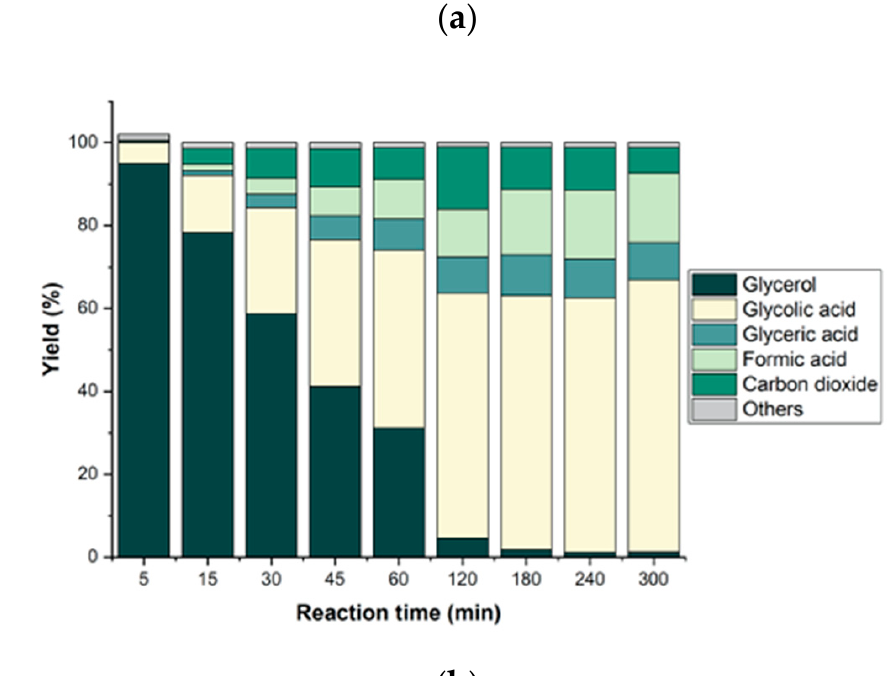
Table 4. Experimental results obtained at each operating conditions of the CCD 1. Test Glycerol Concentration (mol/L) NaOH/Glycerol Molar ratio (mol/mol)